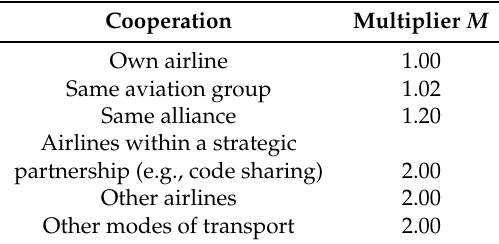
Table 3. Cooperation partners for rebooking passengers to other flights and multiplier M to consider different co-operations in the new ticket price.